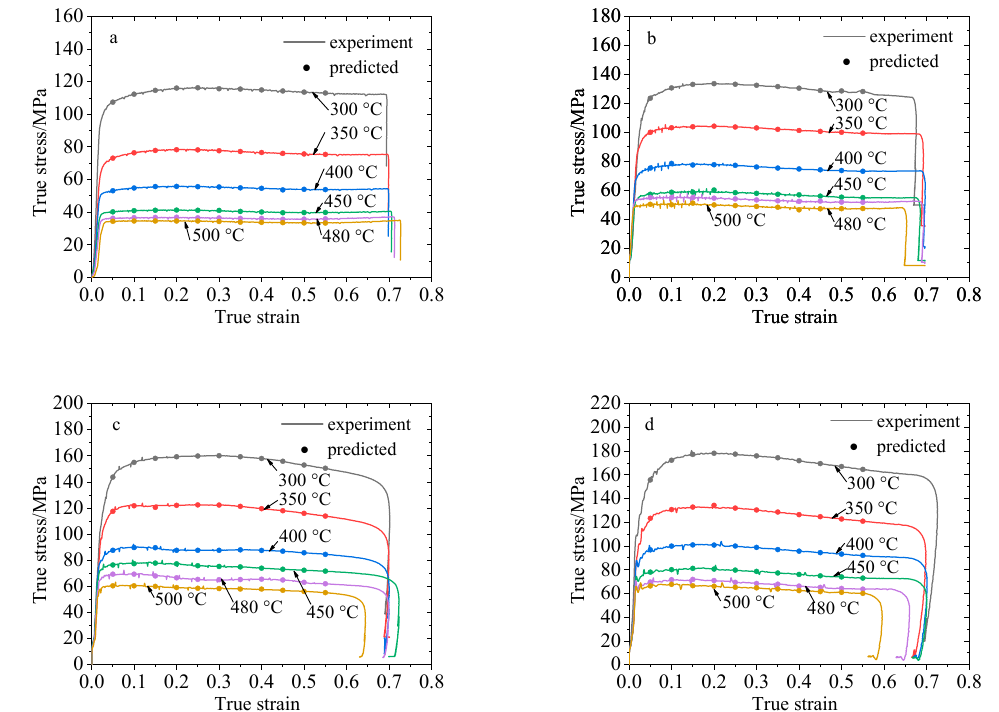
Figure 11. The prediction results for true stress-strain: ( a ) 0.1 s − 1 ; ( b ) 1 s − 1 ; ( c ) 5 s − 1 ; ( d ) 10 s − 1 .